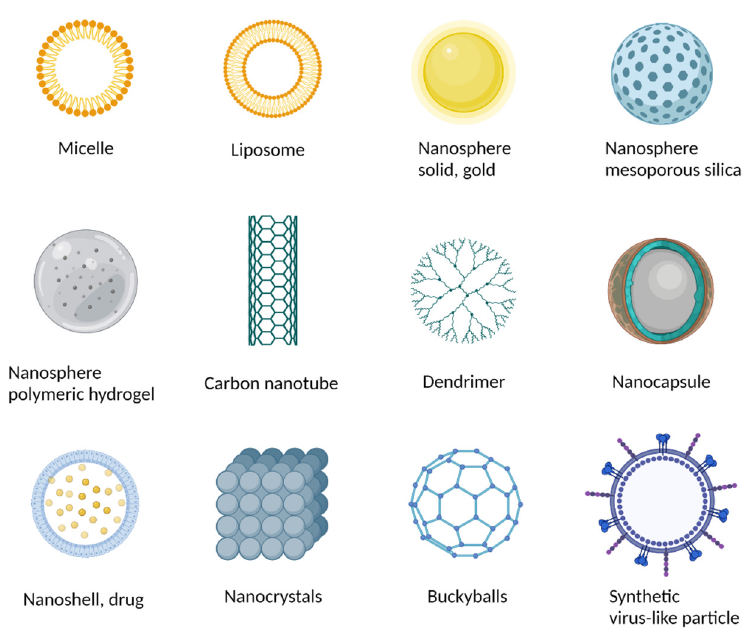
Figure 2. Different types of nanomaterials used in nanomedicine (created with BioRender.com).